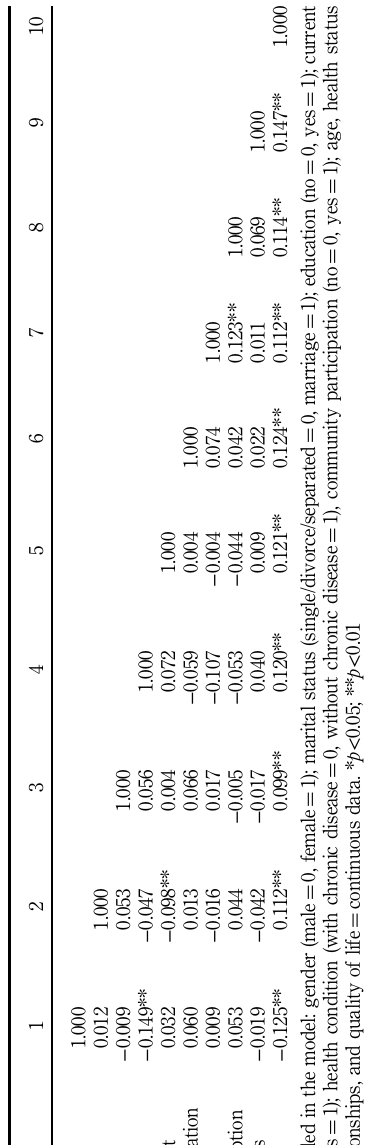
Table III. Correlation coefficients and relationship between predictors; it shows by Correlation